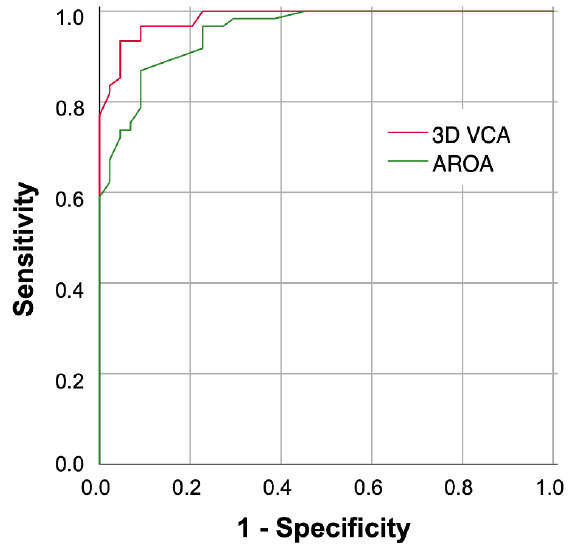
Figure 7. Receiver operating characteristic analysis of 3D VCA (AUC = 0.98) and AROA (AUC = 0.94). Graphical plotting of sensitivity and specificity using different methods to distinguish moderate and severe FMR classified by EROA 2D PISA (cut-off ≥ 0.2 cm 2 ). Abbreviations: AUC = area under the curve; 3D = three-dimensional; VCA = vena contracta area; AROA = anatomic regurgitation area.